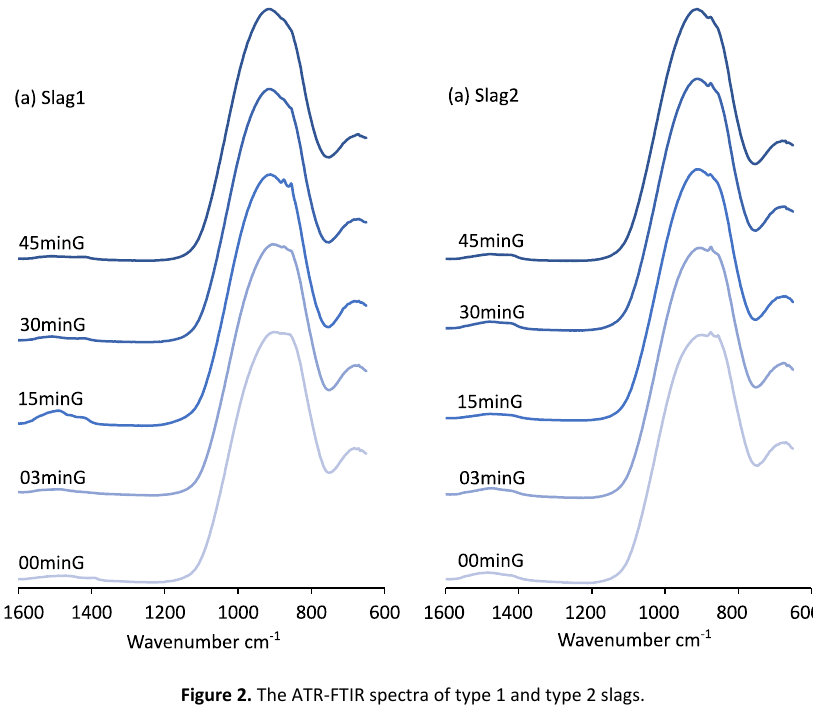
Figure 2. The ATR ‐ FTIR spectra of type 1 and type 2 slags.